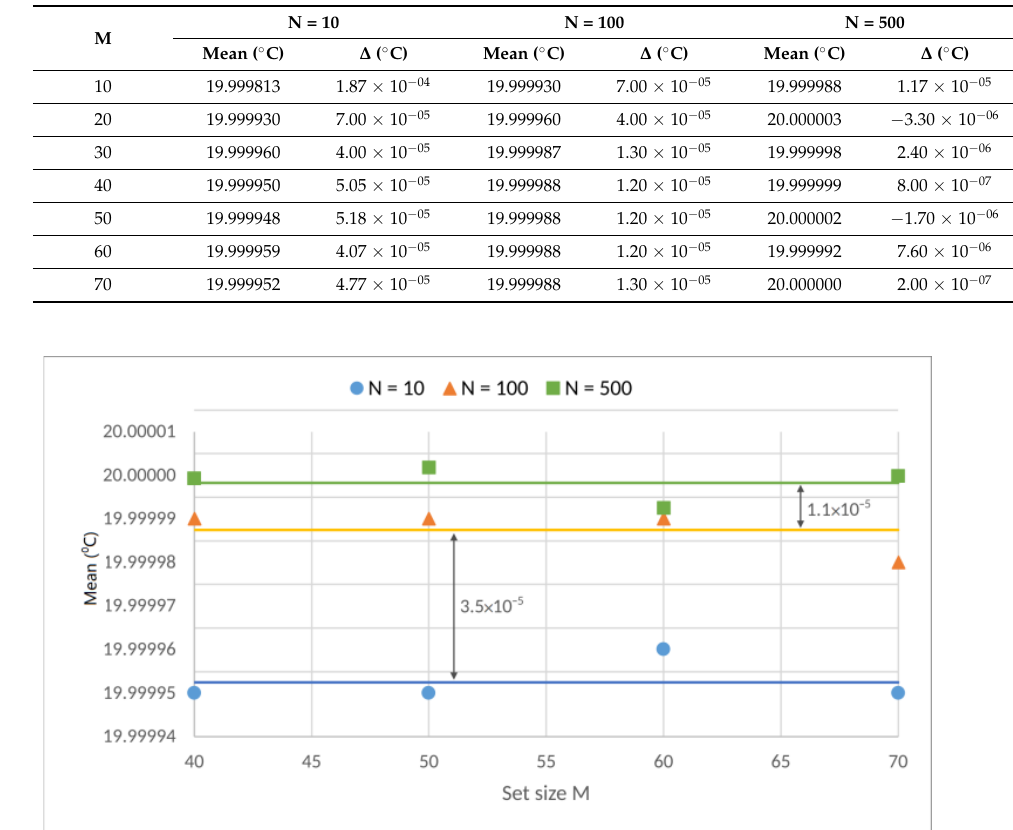
Figure 7. Means and their respective differences for M starting from 40.